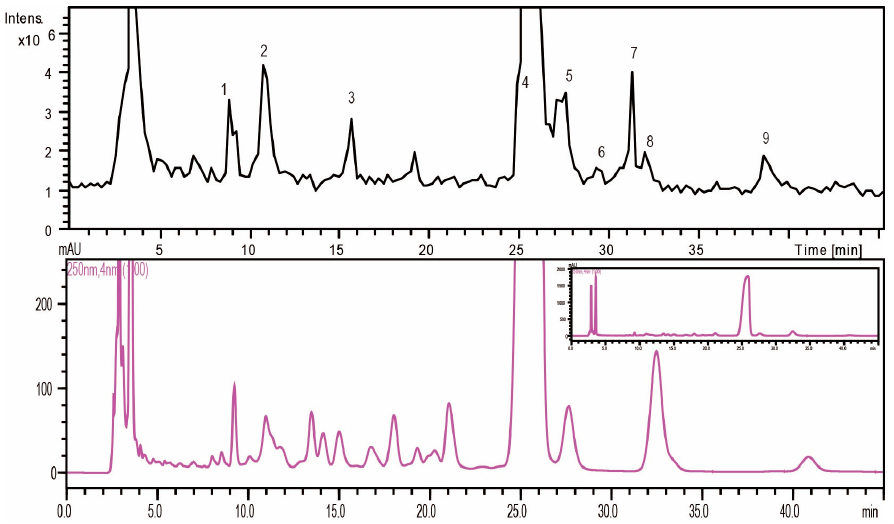
Figure 5. The total ion chromatogram and chromatogram of PMP-labeled monosaccharide composition of polysaccharides.